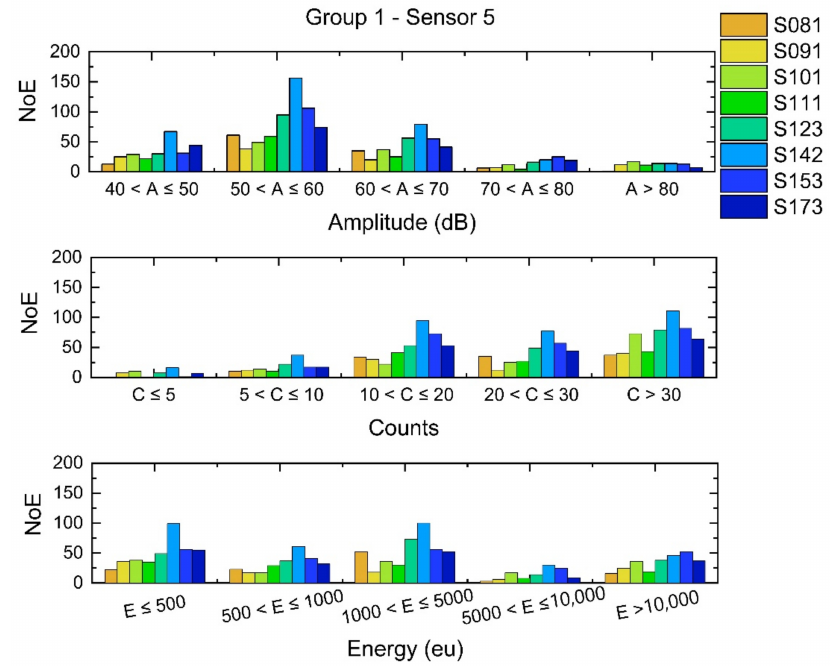
Figure 4. Number of events (NoE) registered during brittle fracture for Group 1 recorded by sensor 5. Each sample is identified by an ID number “Sxxy” corresponding to the number of slices (xx) and the count of the produced sample in the slice (y). ( Top ) amplitude; ( Middle ) counts; ( Bottom ) energy released by the fracture.